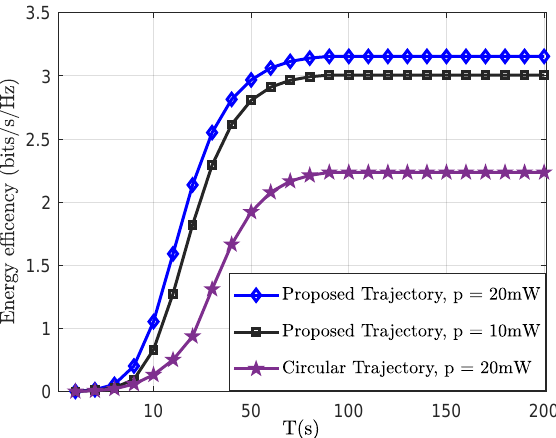
Figure 3. Maximum EE with different trajectory when N =